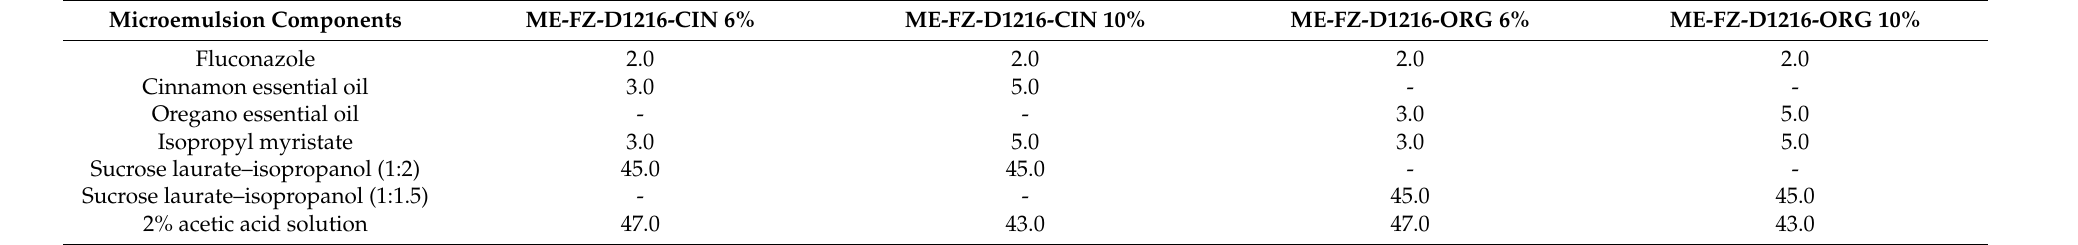
Table 2. Composition (%, w / w ) of fluconazole-loaded microemulsions based on sucrose